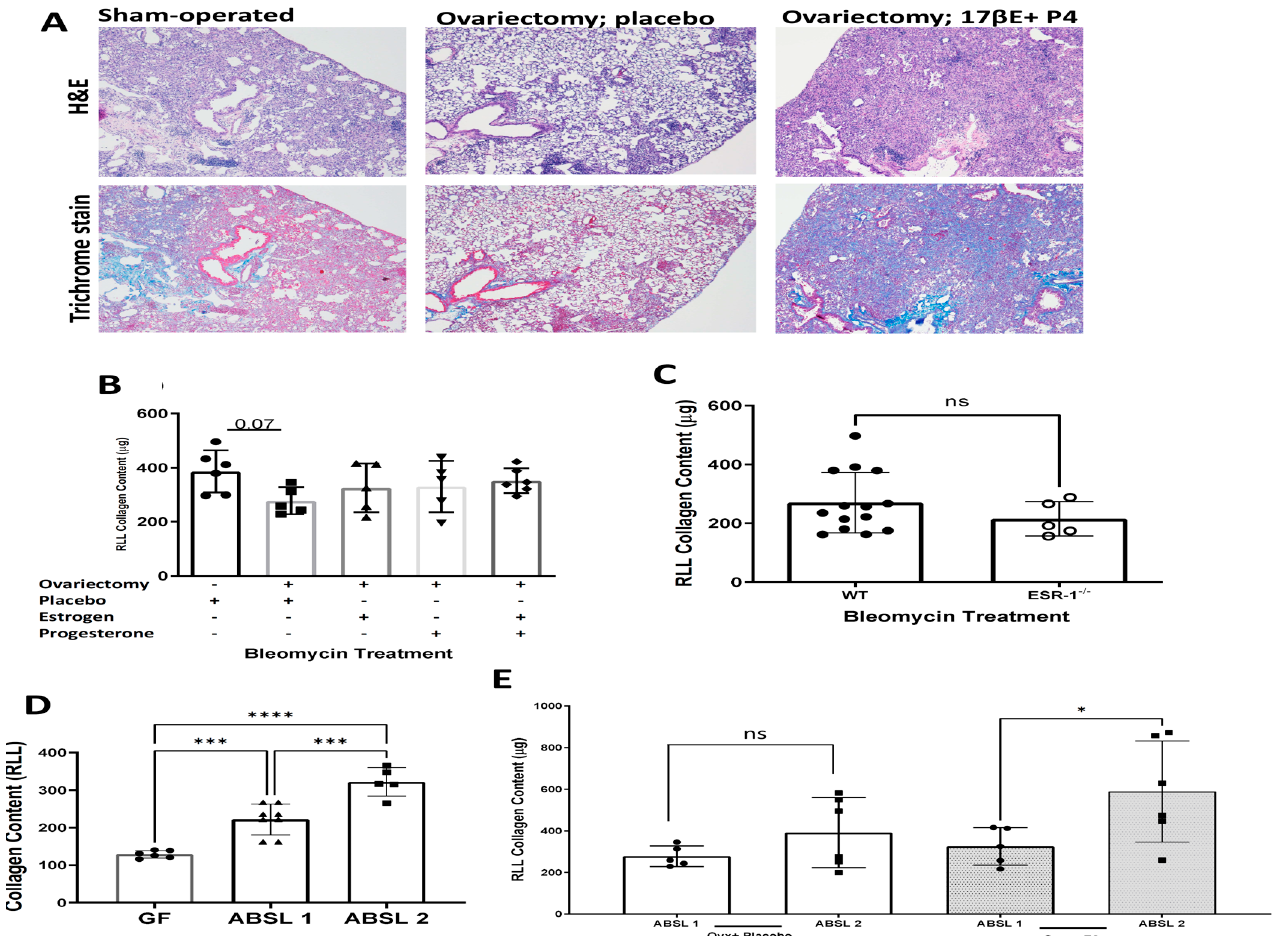
Figure 4. Quantification of bleomycin-induced pulmonary collagen with various hormone dele- tion or repletion conditions in distinct housing environments . ( A ) Representative H&E and trichrome histologic stains of lungs at day 14 under various hormone conditions; ( B ) Pulmonary collagen quantification of the lung under baseline, hormone depletion and hormone repletion con- ditions. ( C ) Pulmonary collagen quantification of the lung under wild-type (WT) and ESR1 null conditions; ( D ) Pulmonary collagen quantification in menstruating female mice housed in germ-free, ABSL-1 and ABSL-2 environments; ( E ) Pulmonary collagen quantification of ovariectomized and estrogen-repleted mice in ABSL-1 and ABSL-2 environments. Comparisons between cohorts were performed using one-way ANOVA with Tukey’s post hoc test. * p < 0.05, *** p < 0.001, **** p < 0.0001. ns: no significance; RLL: right lower lobe. Bars are the mean ± SD; each dot represents an individual mouse. N = 5–14.